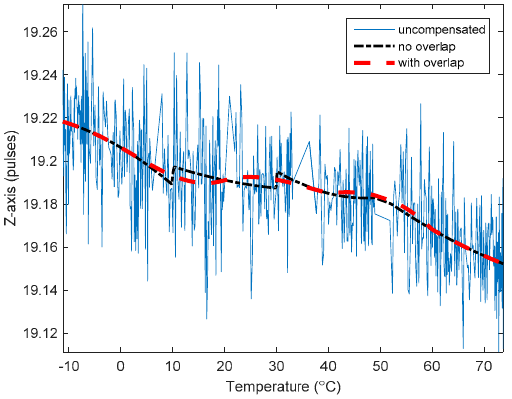
Figure 4. Static output value of the Z -axis RLG and its fitted curve—with and without overlap. Table 1. The RLGs bias before and after temperature compensation (pulses).